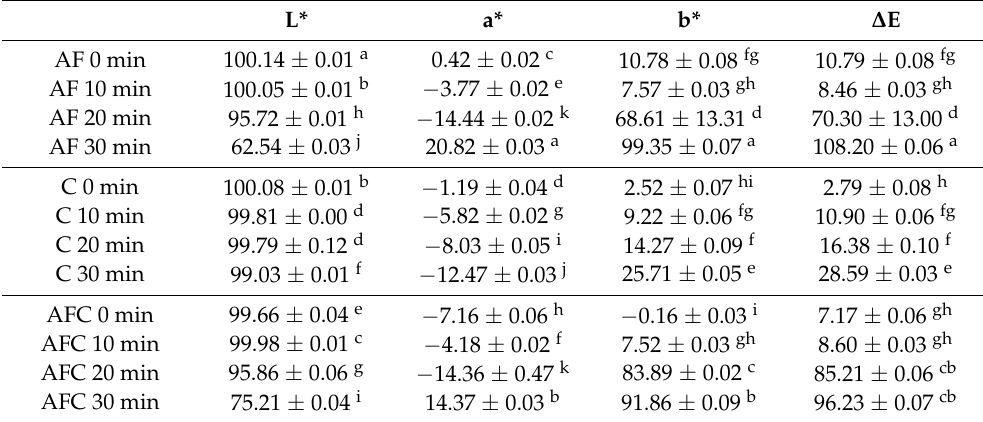
Table 2. Chromatic parameters of solutions containing the combination of asparagine, fructose, and chitosan dissolved in 1% acetic acid and titrating back to pH